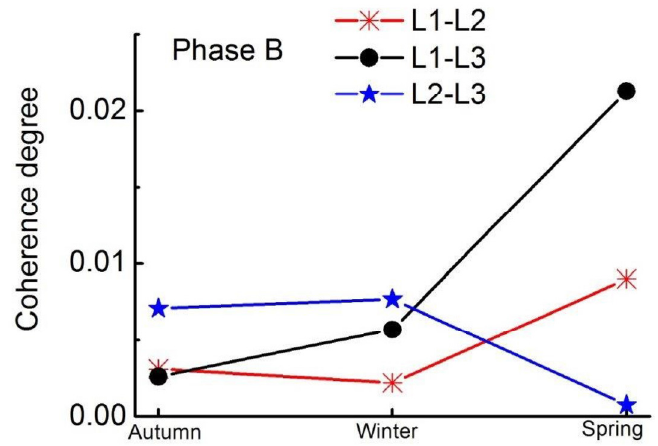
Figure 8. Coherence degree between two lines PC sigs , based on the currents flowing into a fixed and arbitrary phase.